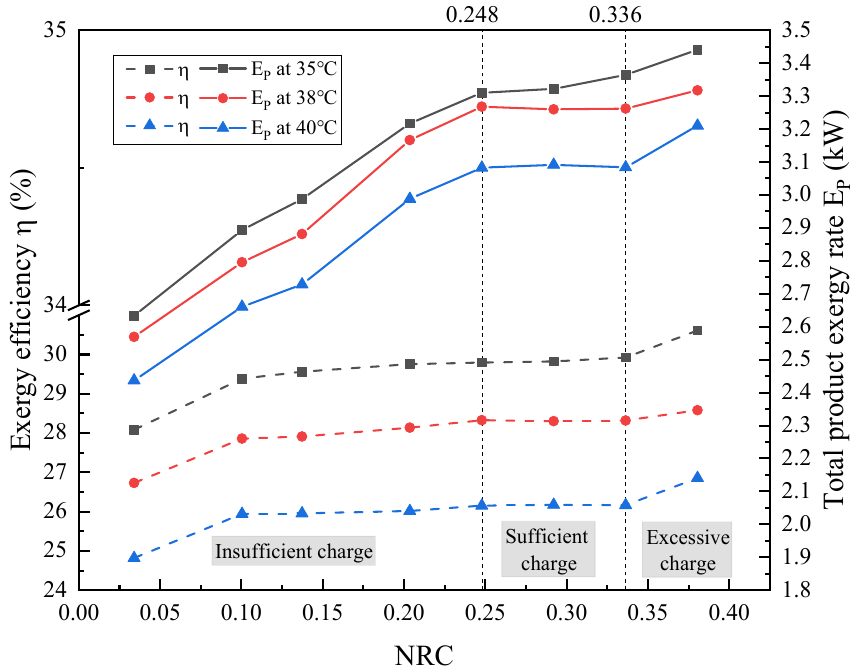
Figure 6. The effect of normalized refrigerant charge (NRC) on exergy efficiency ( η ) and total product exergy rate ( 𝐸̇ (cid:3017),(cid:3047)(cid:3042)(cid:3047) ) corresponding to the optimal COP at ambient temperatures of 35 °C, 38 °C and 40 °C.